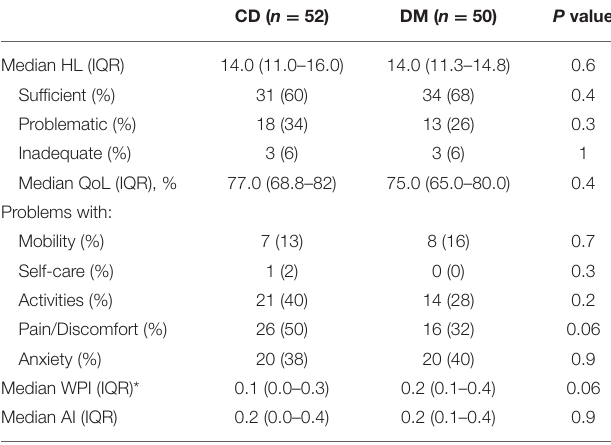
TABLE 2 | Comparison of the questionnaires’ variables between CD and DM